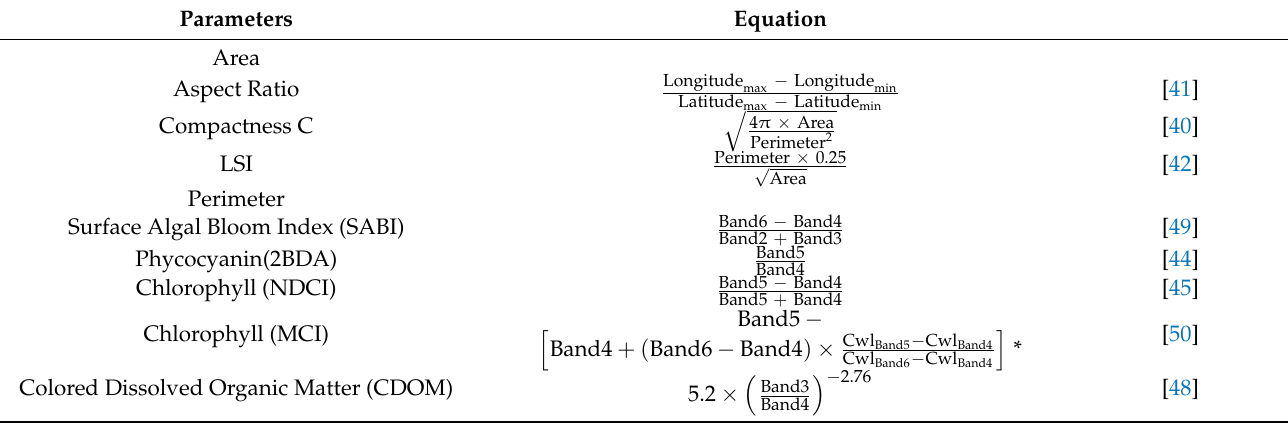
Table 4. Shape and water quality